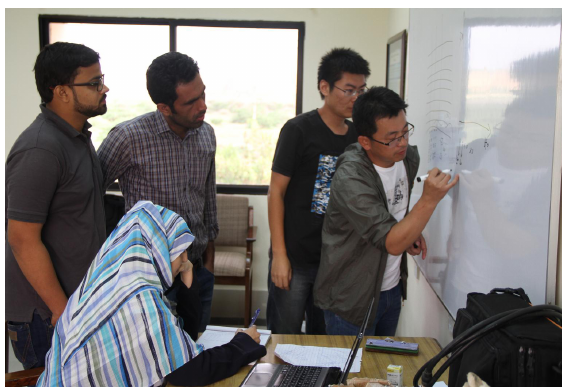
Figure 12. An image captured during one of the training